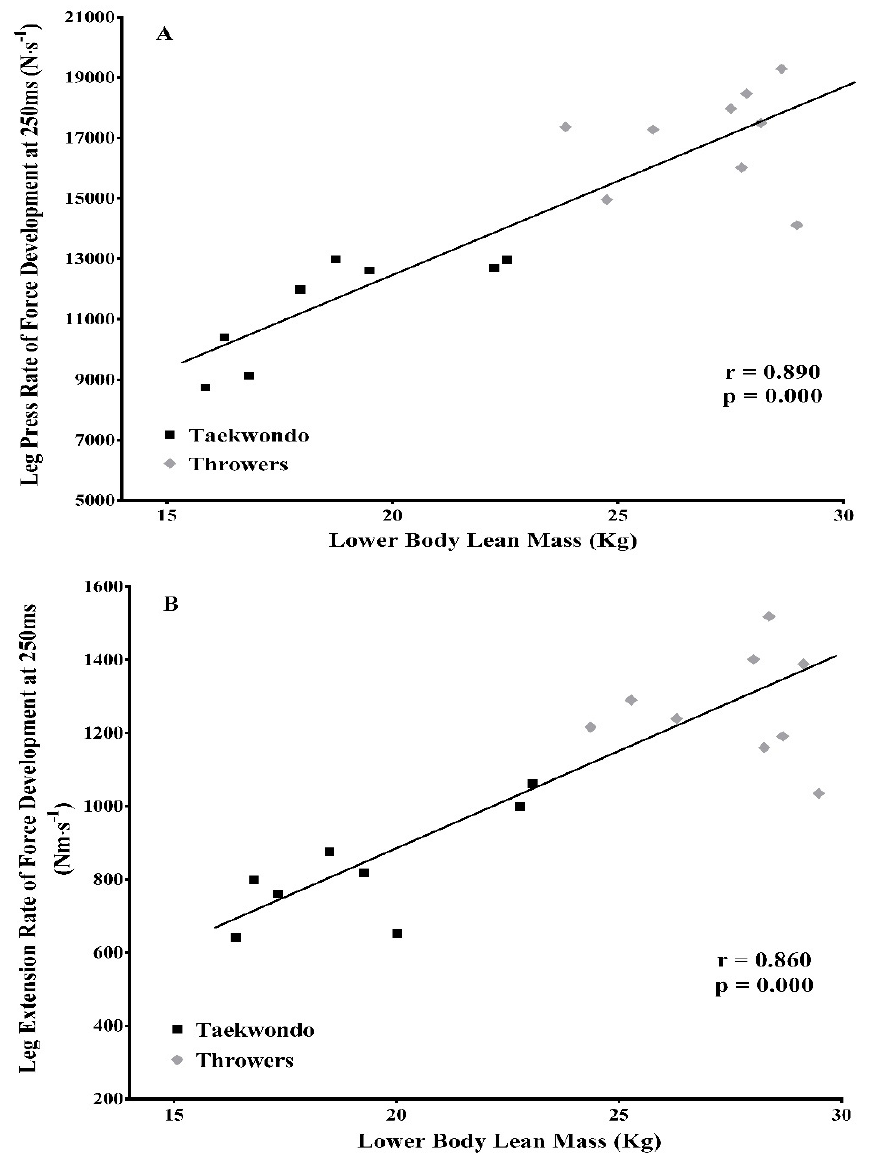
Figure 6. ( A ) Significant correlation between lower body lean mass and leg press RFD for taekwondo athletes (black dots) and track and field throwers (grey dots). ( B ) Significant correlation between lower body lean mass and leg extension RFD for taekwondo athletes (black dots) and track and field throwers (grey dots).